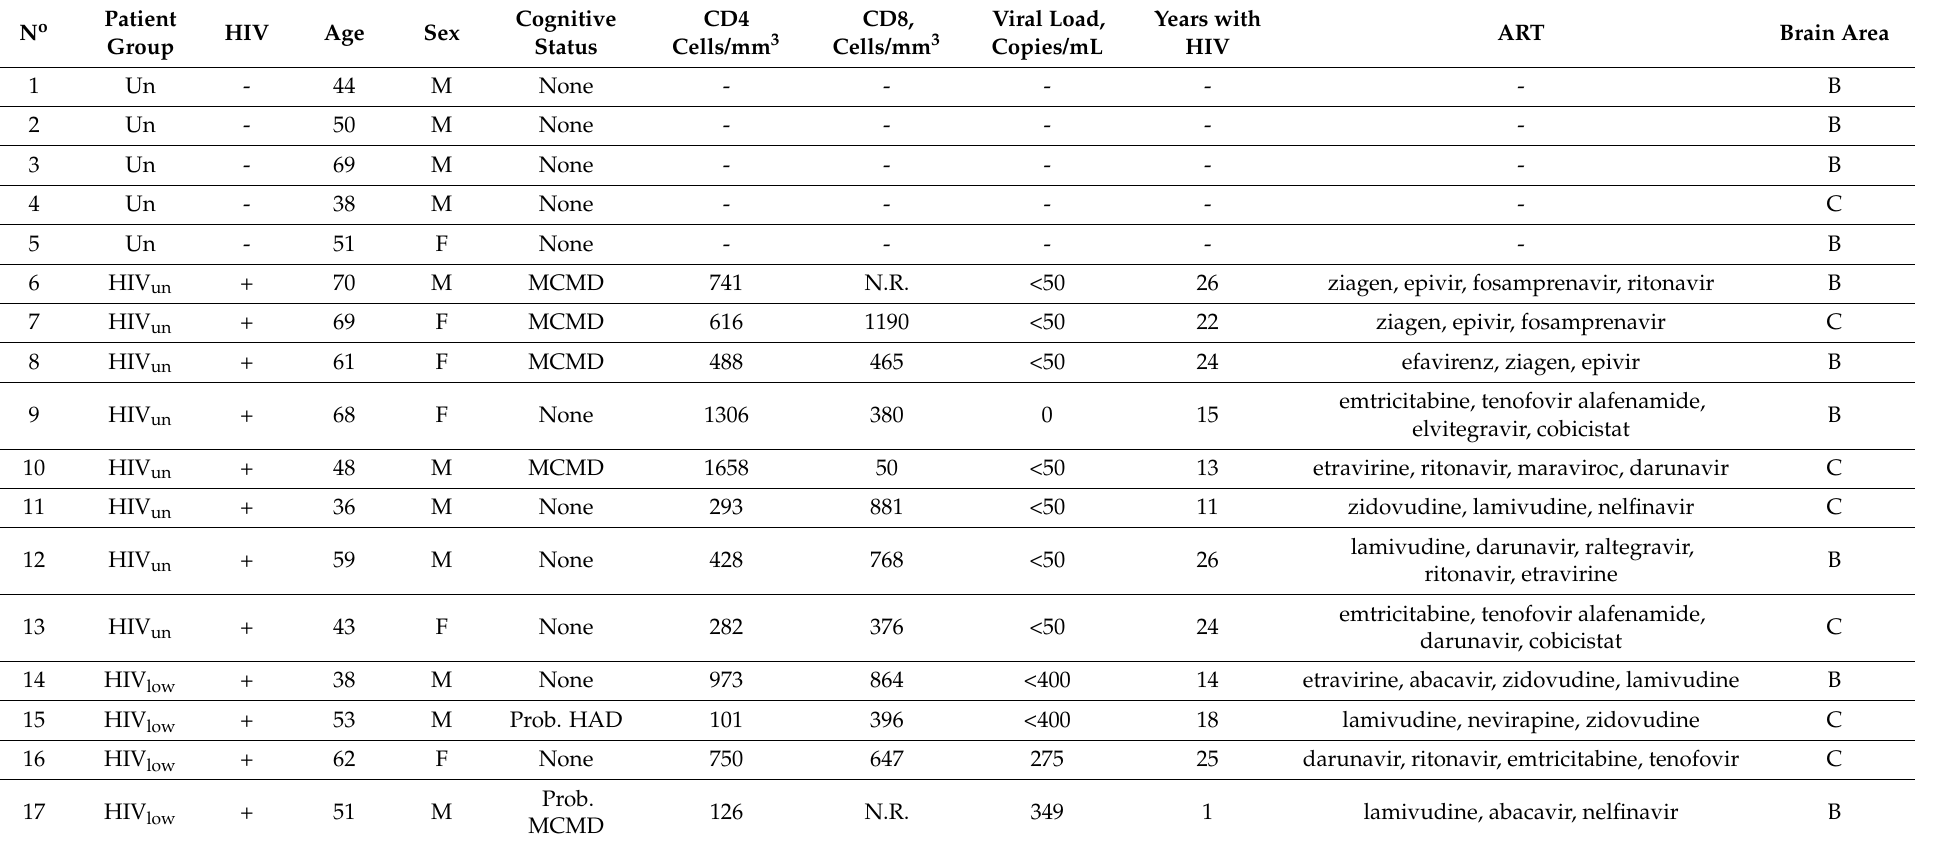
Table 1. Patient information for the samples analyzed. Information from all 34 individual donors of brain tissue samples regarding HIV status, age, sex, cognitive status, CD4 + T-cell counts (cells/mm 3 ), CD8 + T cells (cells/mm 3 ), viral load (copies/mL), years living with HIV, and ART treatment description. Patient Group—Un: uninfected/HIV-negative group; HIV un : HIV positive, viral load under the limit of detection; HIV low : HIV positive, low-viral-load group; HIV high : HIV positive, high-viral-load group; HIVE: HIV positive, archival encephalitic group; Alz: Alzheimer’s group. Cognitive status—MCMD: minor neurocognitive and motor disorder, HAD: HIV-associated dementia. ART: antiretroviral. CD4, CD8 T-cell counts—N.R.: not reported. Brain Section—C: cortex, H: hippocampus, B: cortex and